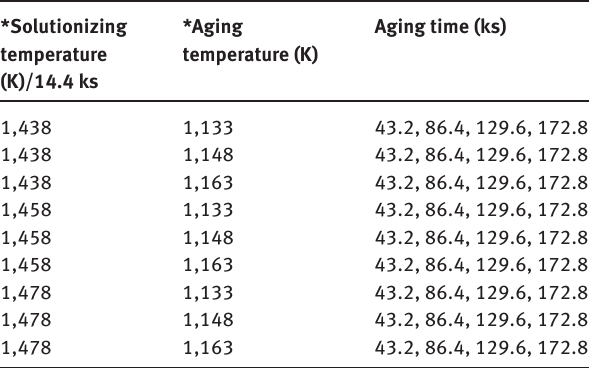
Table 2: Reheat treatment